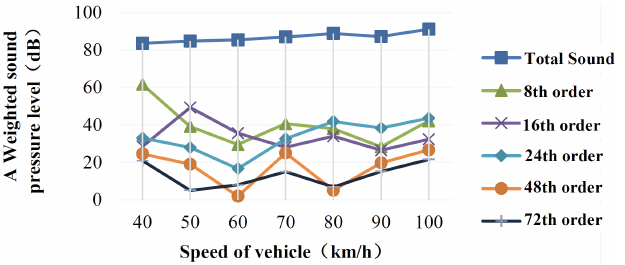
Fig. 13. Noise Order analysis of power cabin (acceleration condition).